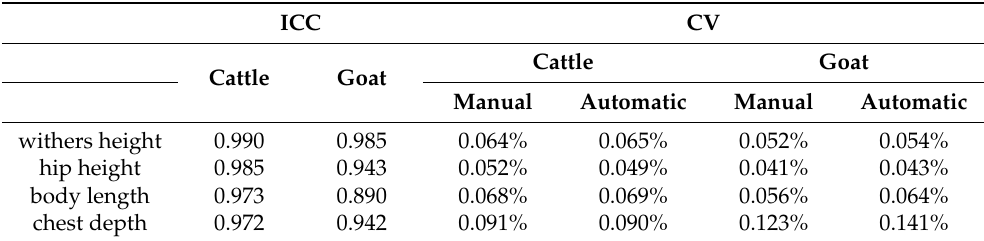
Table 5. The analysis results of repeatability and reproducibility *. ICC CV Cattle Goat Cattle Goat Manual Automatic Manual